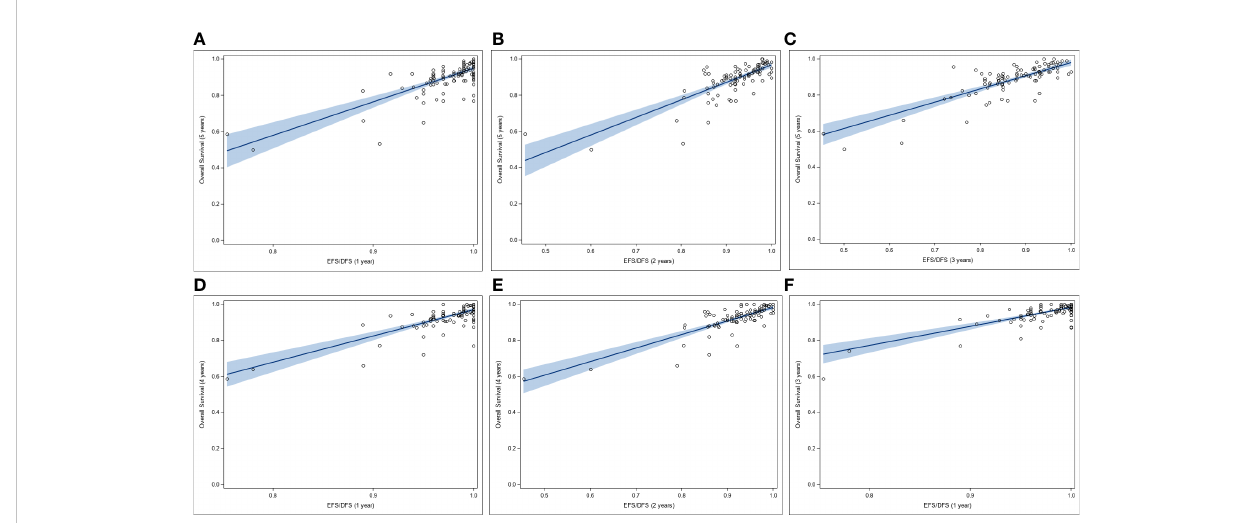
FIGURE 3 Correlation between rates of OS and rates of EFS/DFS at landmark time points (A-C) , Correlation between 5-yr OS rates and (A) 1-yr, (B) 2-yr, and (C) 3-yr rates of EFS/DFS. (D, E) , Correlation between 4-yr OS rates and (D) 1-yr, and (E) 2-yr rates of EFS/DFS. (F) Correlation between 3-yr OS rates and 1-yr rates of EFS/DFS. DFS, disease-free survival; EFS, event-free survival; OS, overall survival.